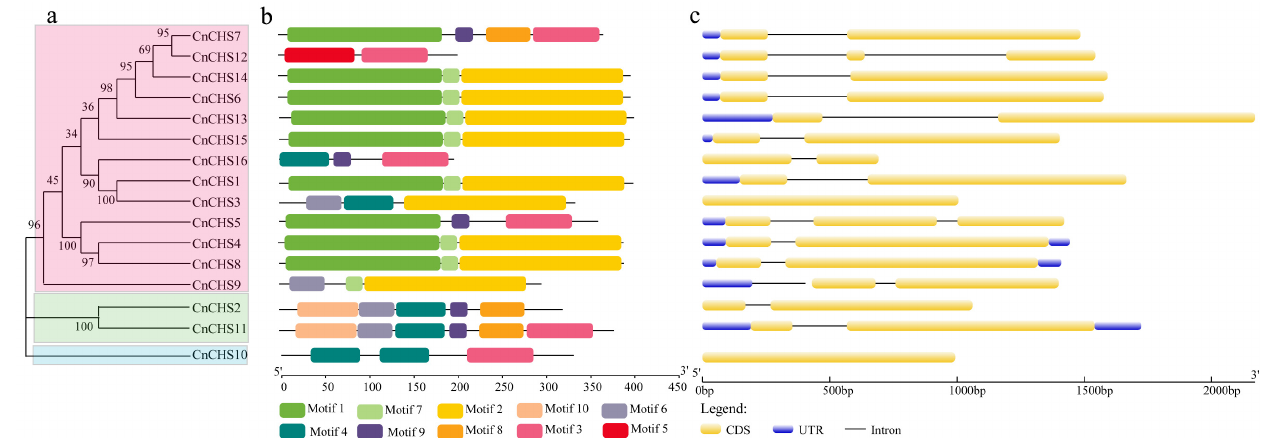
Figure 3. Phylogenetic analysis, gene structures, and motif analysis of the CnCHS genes. ( a ) Phylo- genetic tree of the CnCHS genes. ( b ) Motif analysis of CnCHS members. Differently colored blocks represent different motifs. ( c ) Gene structure of the CnCHS genes. The blue blocks represent the upstream/downstream the yellow blocks represent the coding sequences (CDS), and the black lines represent the introns.